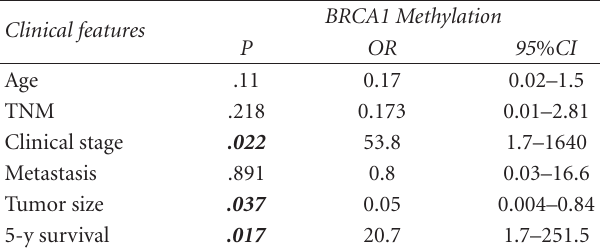
Table 3: Multivariate analysis of BRCA1 methylation status and clinical